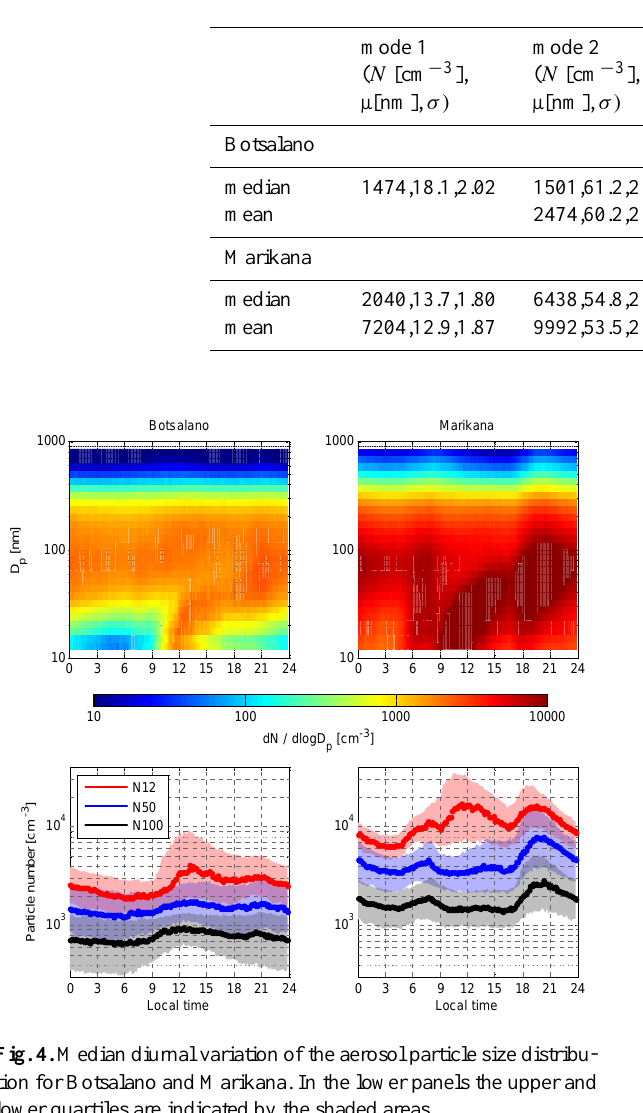
Table 2. Size distribution parameters for Botsalano and Marikana. Negative mean relative error (MRE) values indicate overestimation by the modal fits.